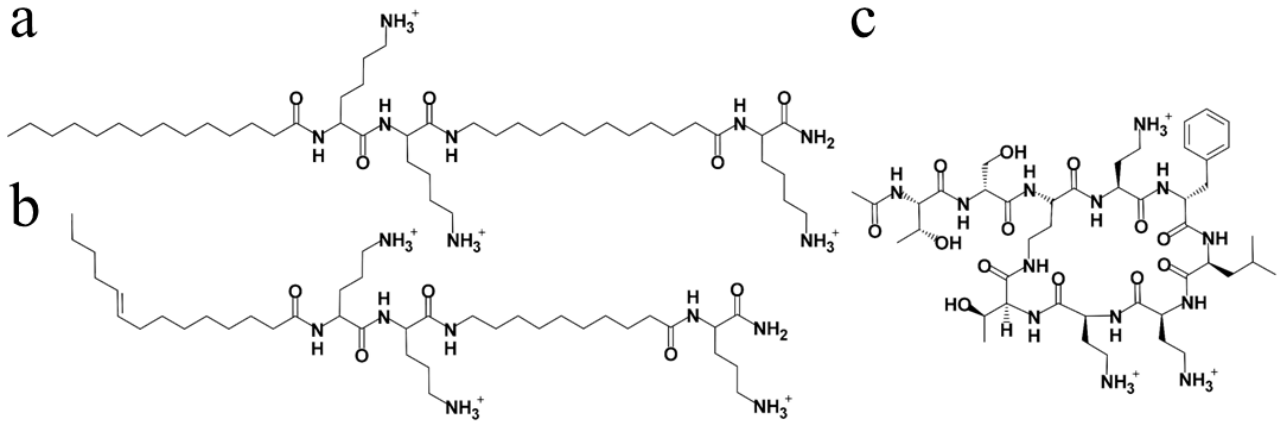
Figure 1. Molecular structures of two main tested OACs and a comparator. ( a ) C 14 KKc 12 K (MW: 809); ( b ) C 14( ω 5) OOc 10 O (MW: 737); ( c ) PMB derivative SPR741 (MW: 992). In ( a , b ) the C-terminus is amidated, the letters C and c, respectively, denote an acyl and aminoacyl whose length (number of carbon atoms) is defined by the subscript; the parenthesis ( ω 5) in ( b ) denotes the position of a double bond; K and O represent the amino acids lysine and ornithine, respectively.